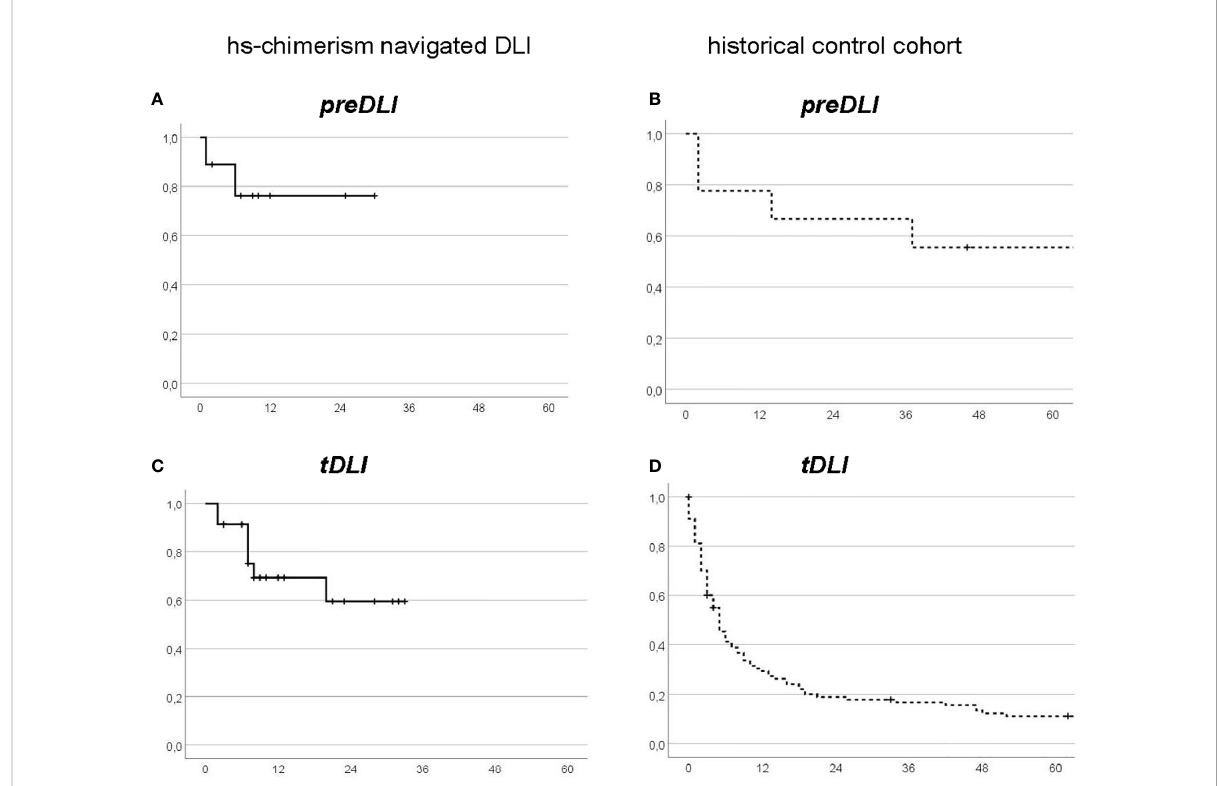
FIGURE 3 Landmark Overall Survival from fi rst DLI, by DLI intention: preDLI (A, B) versus tDLI (C, D) in the hs-chimerism navigated group (A, C) or the historical control group (B, D) , respectively. x-axes: months after fi rst